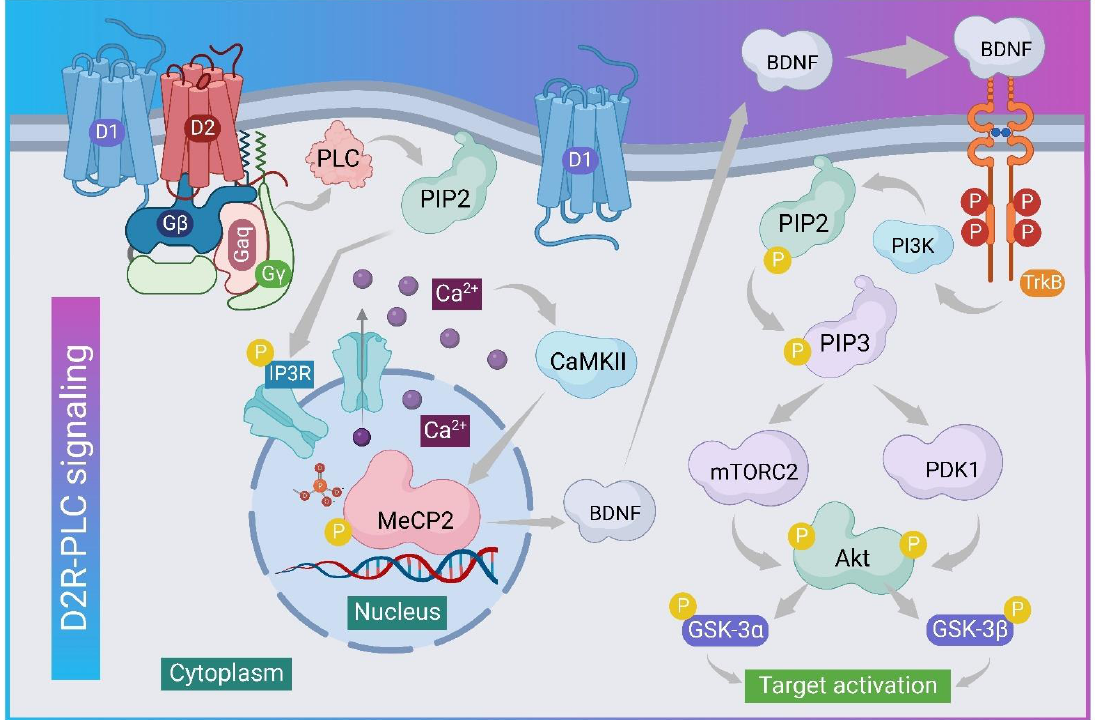
Figure 2. The graphic depicts the phosphorylation of several proteins at various levels of signaling to activate BDNF from MeCP2 inside the nucleus to activate the TrkB receptor for the activation of PIP3 to mTORC2 and PDK1 proteins, followed by Gsk to reach the target for